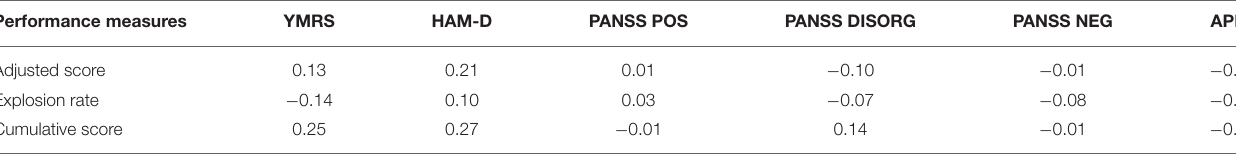
APD, antipsychotic dose; DISORG, Disorganization score; HAM-D, Hamilton Rating Scale for Depression; NEG, Negative symptom score; PANSS, Positive and Negative Syndrome Scale; POS, Positive symptom score; YMRS, Young Mania Rating Scale. a Pearson correlation analyses were performed and r values were presented. b Antipsychotic dose was quantified using chlorpromazine equivalents (mg/daily).